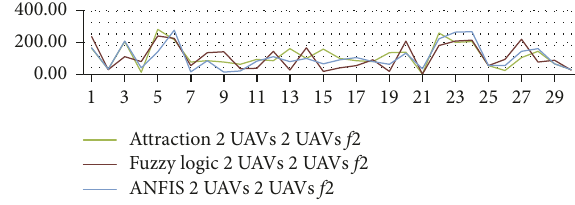
Figure 22: La Palma results comparison for 2 UAVs in distributed formation.